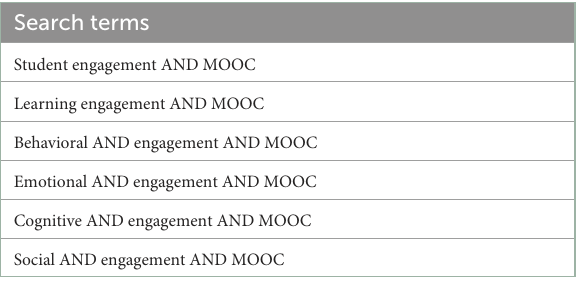
TABLE 1 Keyword combinations used in database